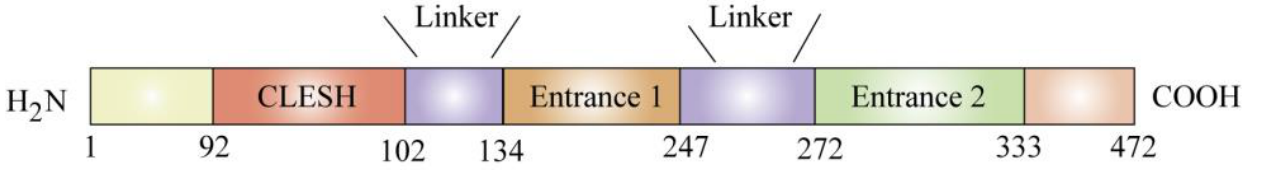
Figure 1. CD36 primary structure. The CLESH structural domain in CD36 can regulate tumor angiogenesis by interacting with the TSR. CD36 forms two hydrophobic lumens (entrance 1 and en- trance 2) in its pericyte region and binds to hydrophobic lipid-associated proteins to regulate cel- lular lipid metabolism.